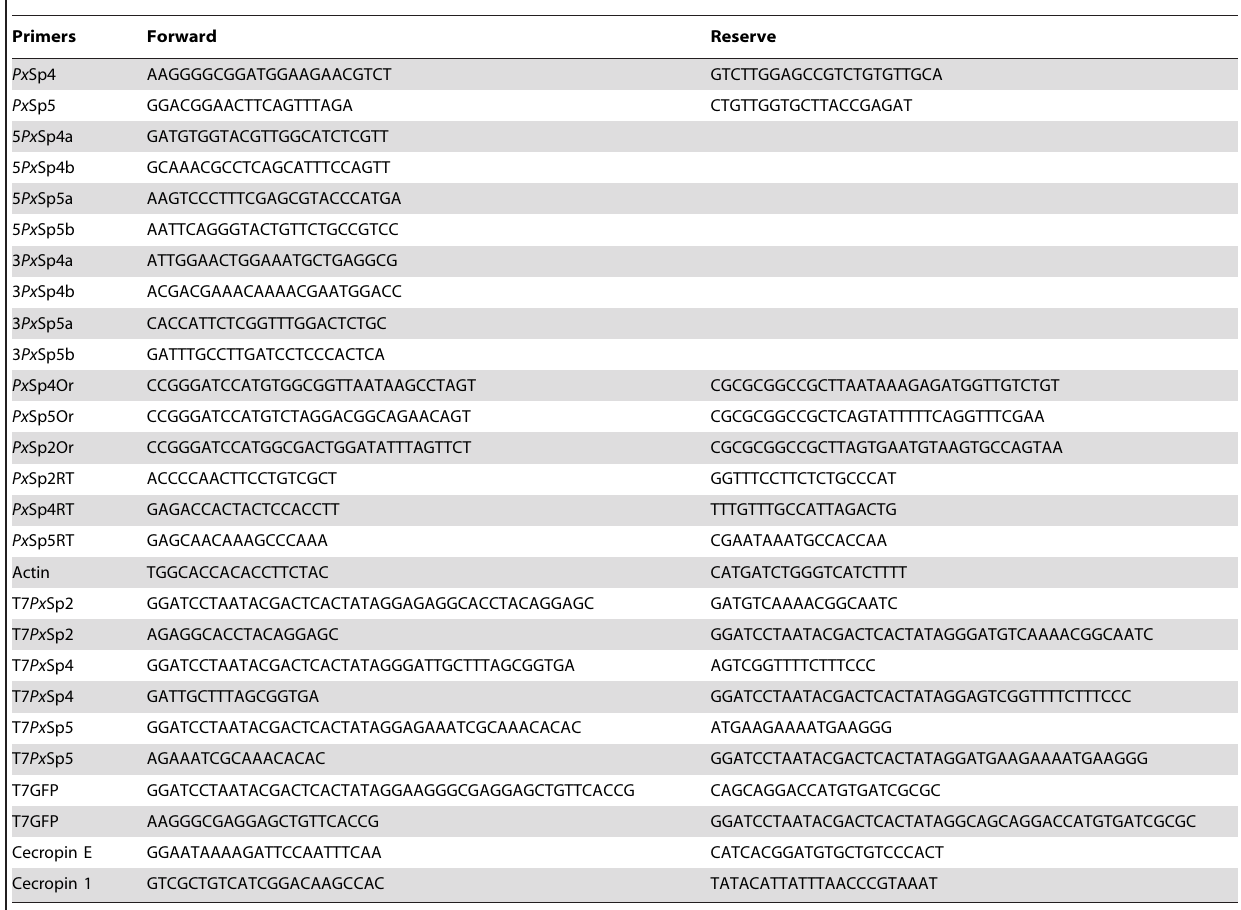
Table 1. The primer sequences used in the